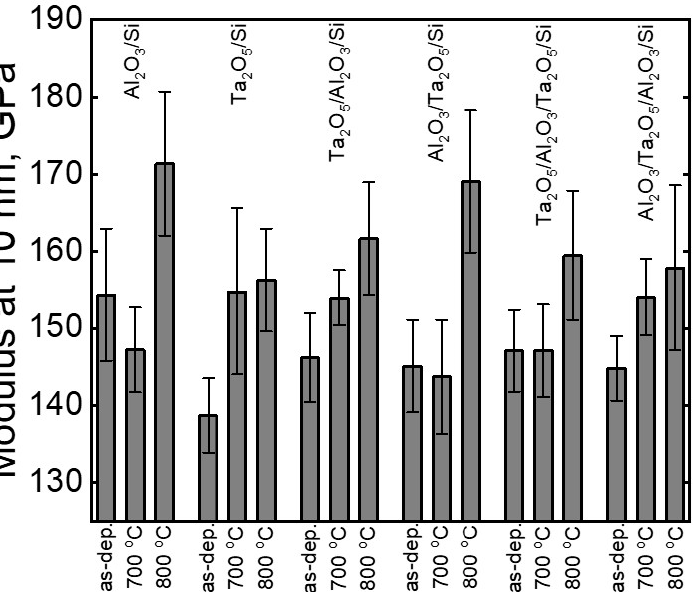
Figure 13. Average elastic moduli with standard deviations at 10 nm for all the measured films in their as-deposited states and after annealing at two different temperatures, as indicated by the notations on X-axis. The stacked structures evaluated by indentation are described by labels above data bars.